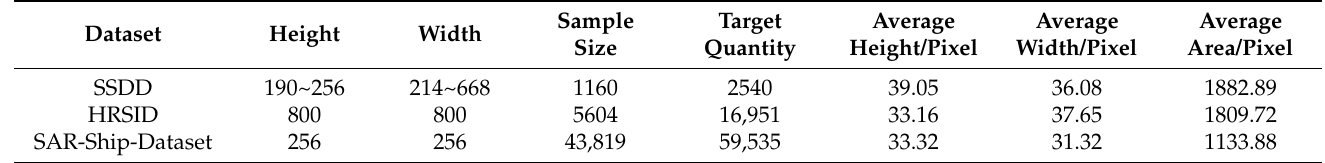
Table 5. Information table of SAR ship dataset.